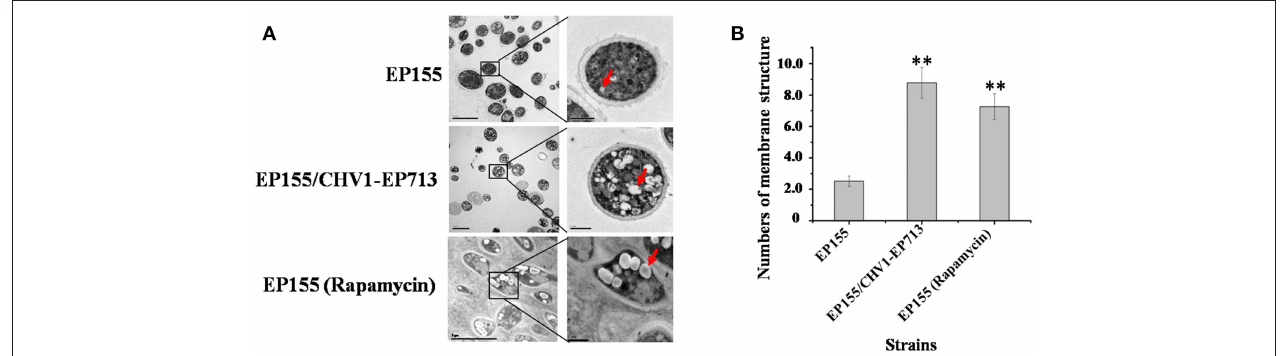
FIGURE 1 | Hypovirus infection and rapamycin treatment resulted in the accumulation of autophagosome-like vesicle. (A) Transmission electron micrographs of the hyphae. The hypha morphology of EP155 and EP155/CHV1-EP713 did not show apparent distinction. However, the intracellular structure of EP155/CHV1-EP713 showed much more membrane structures. Arrow indicates autophagosome-like vesicle. (B) The quantification of the average number of autophagosome-like vesicles per cell and a minimum of 20 cells were counted. Rapamycin-treated EM graphs (14 days on rapamycin-supplemented PDA plate). ** indicates P < 0.001, determined by Student’s t -test.